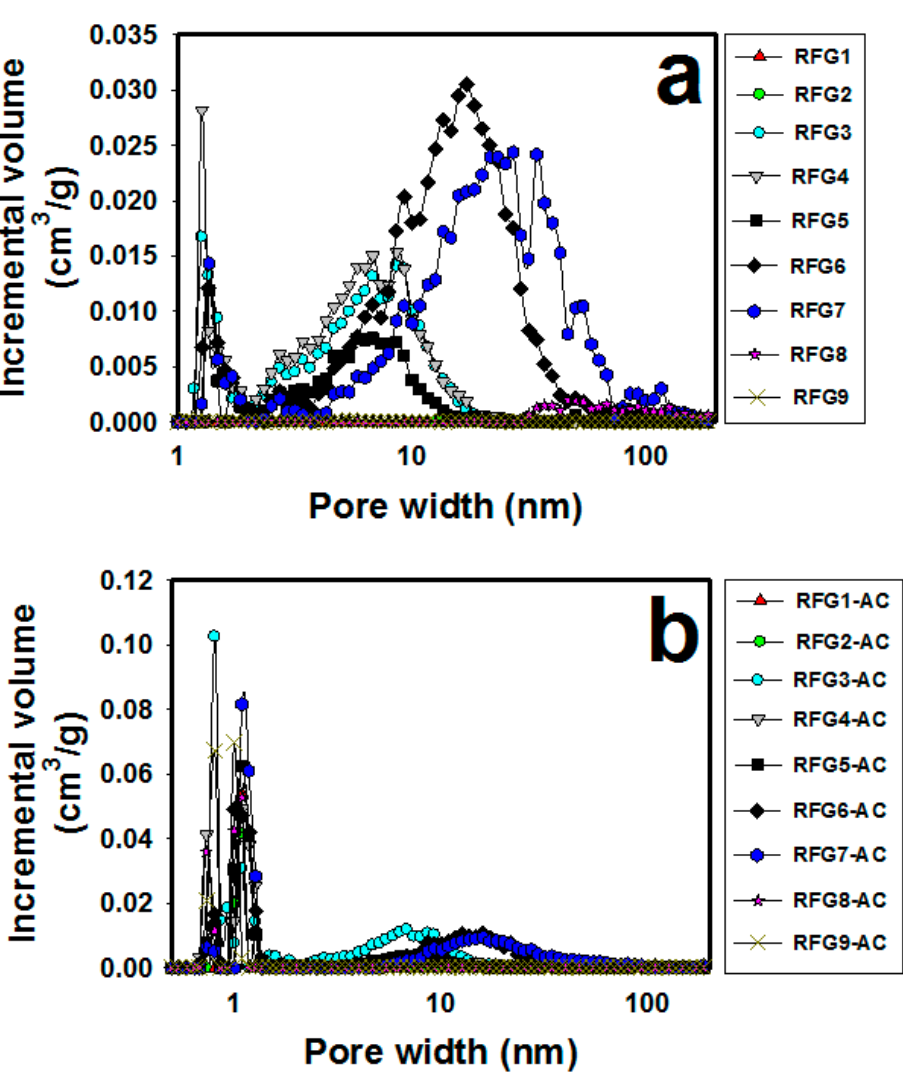
Figure 9. Incremental pore volume area versus pore width of ( a ) RFG n and ( b ) RFG n -AC samples .